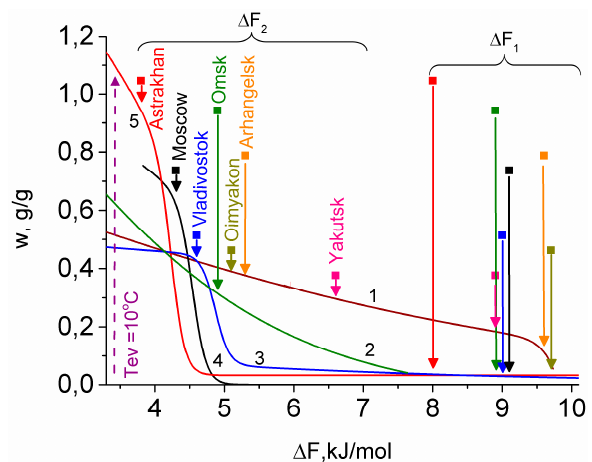
Figure 6. Boundary conditions (vertical lines) for the adsorption heat storage cycles ( T ev = T n.av, T con = T d.av, T uh = 35 °C, T reg = 90 °C) tested and the universal adsorption curves for: 1—LiBr/SiO 2 , 2—MaxSorbIII, 3—UiO67, 4—LiCl/SiO 2 , 5—LiCl/MWCNT. The refrigerant is methanol.